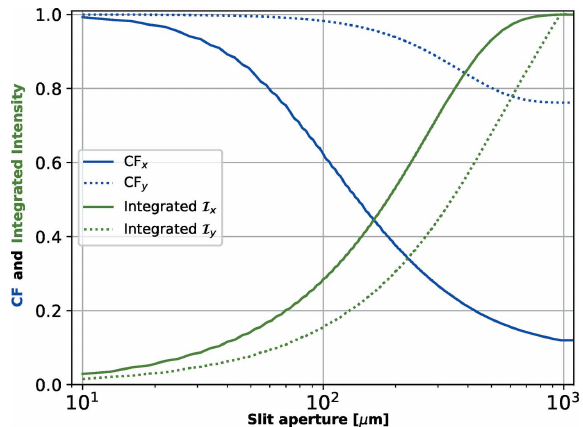
Figure 7 Coherent fraction (blue) and normalized integrated intensity (green) versus aperture for the horizontal (solid) and vertical (dotted) directions calculated by WOFRY1D at 7 keV.